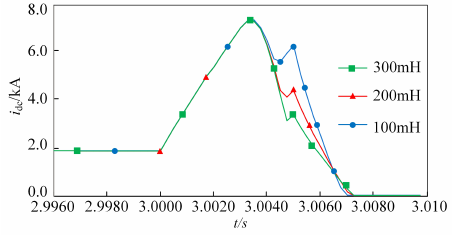
Fig. 7. Relationship between current limiting reactance L and i dc